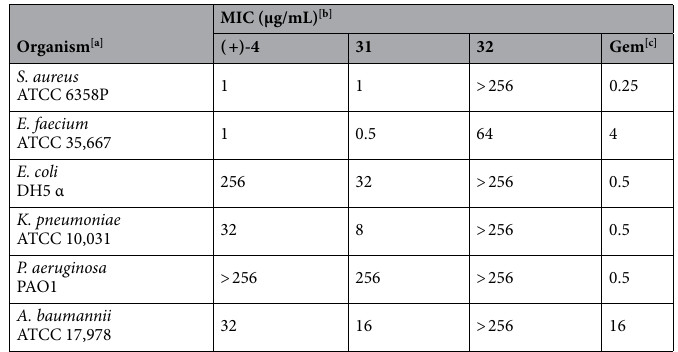
Table 1. Antimicrobial evaluation of the synthesized hygrophorones (+)- 4 , 31 , and 32 using clinically relevant bacterial pathogens. Determined by CLSI broth microdilution methods. [a] Measured concentration (0.125–256 µg/mL); S. aureus : Staphylococcus aureus ; E. faecium : Enterococcus faecium ; E. coli: Escherichia coli; K. pneumoniae: Klebsiella pneumoniae; P. aeruginosa: Pseudomonas aeruginosa; A. baumannii: Acinetobacter baumannii. [b] MIC: Minimum inhibitory concentration. [c] Gem: gentamicin. Measured concentration (0.125–16 µg/mL).